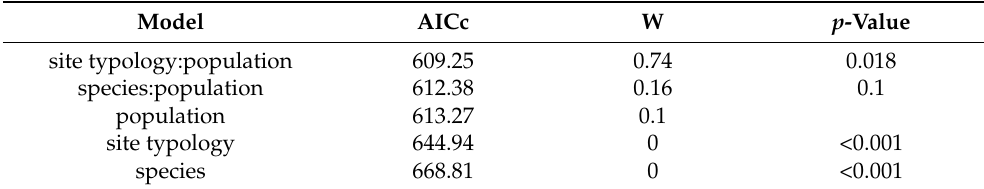
Table 2. Model ranking of candidate models used to analyse the dependence of axilla-groin distance of salamanders based on the species ( Salamandrina perspicillata or S. terdigitata ), the type of breeding site (brook or lentic water) and their population (five populations). Species and site type were used as fixed factors, population as a random factor (when together, the random factor is nested in the fixed one). AICc is the Akaike’s information criterion for small sample size, w is the model weight. p -value refers to the fixed factor for the given ANOVA model.